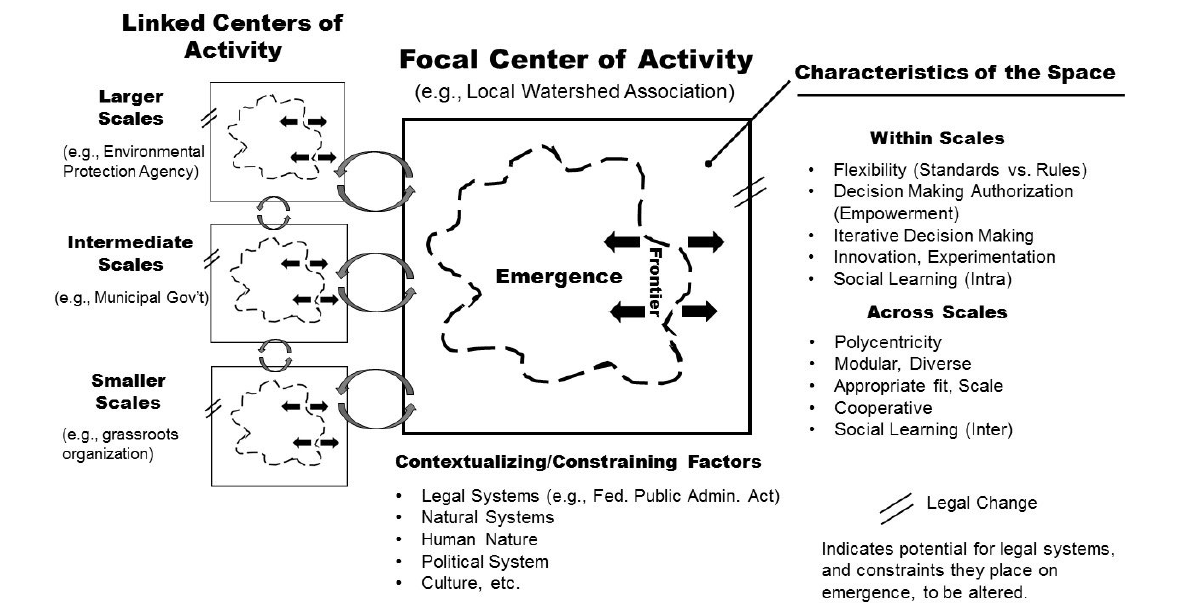
Fig. 2 . Emergence frontiers. Representation of a focal center of activity or decision arena, and its polycentric (linked) connections; explicitly highlights emergence and enabling/constraining features. Circular arrows represent reciprocal